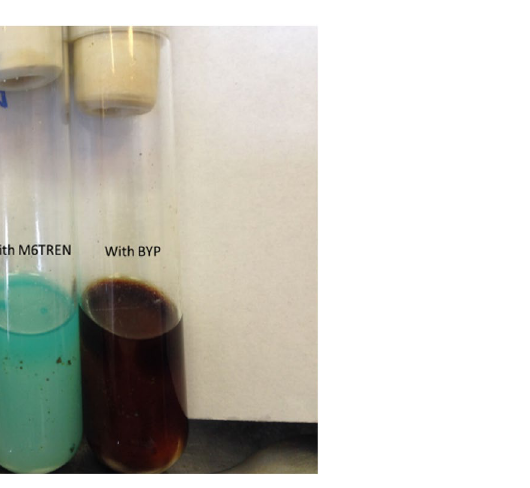
Figure 6. GPC analyses for BA polymerization without any ligand, with Me 6 TREN and with BiPy.